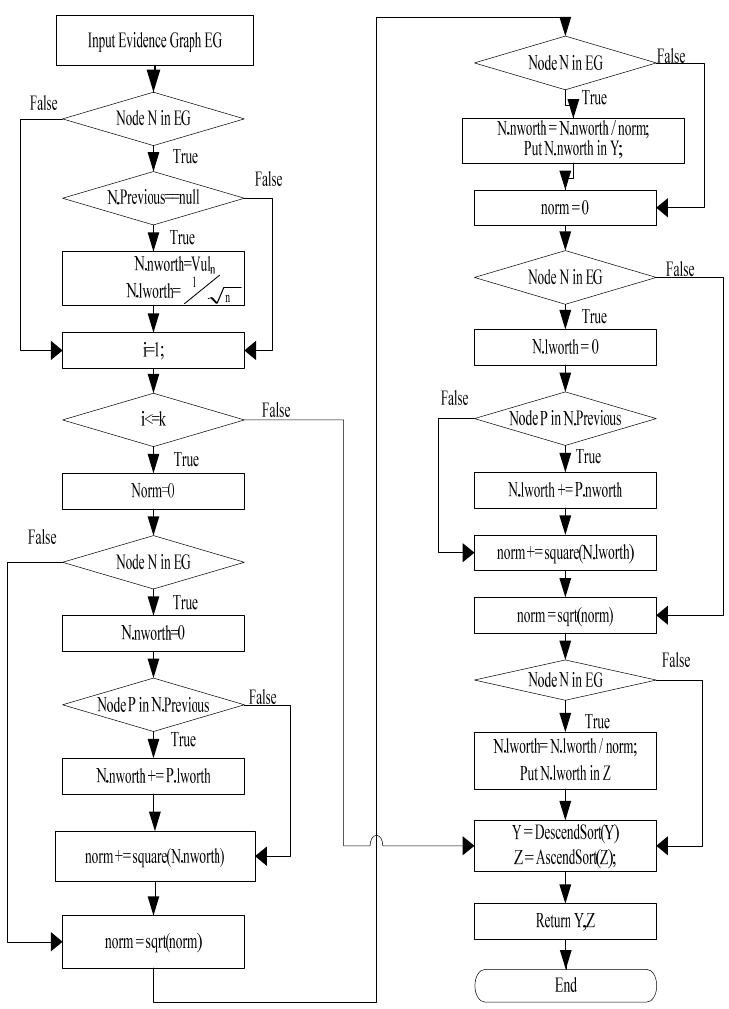
Figure 4. The Procedure for Vulnerability Evidence Reasoning